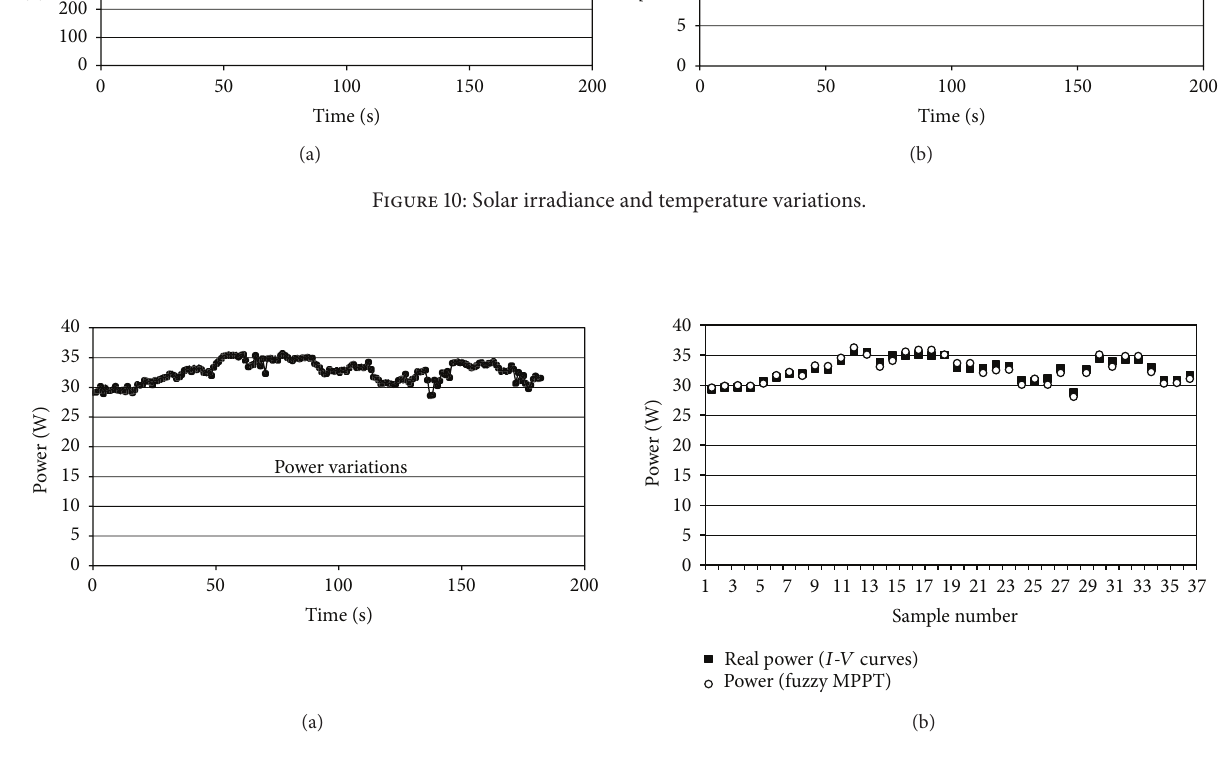
Figure 11: Tracking the MPP using the fuzzy